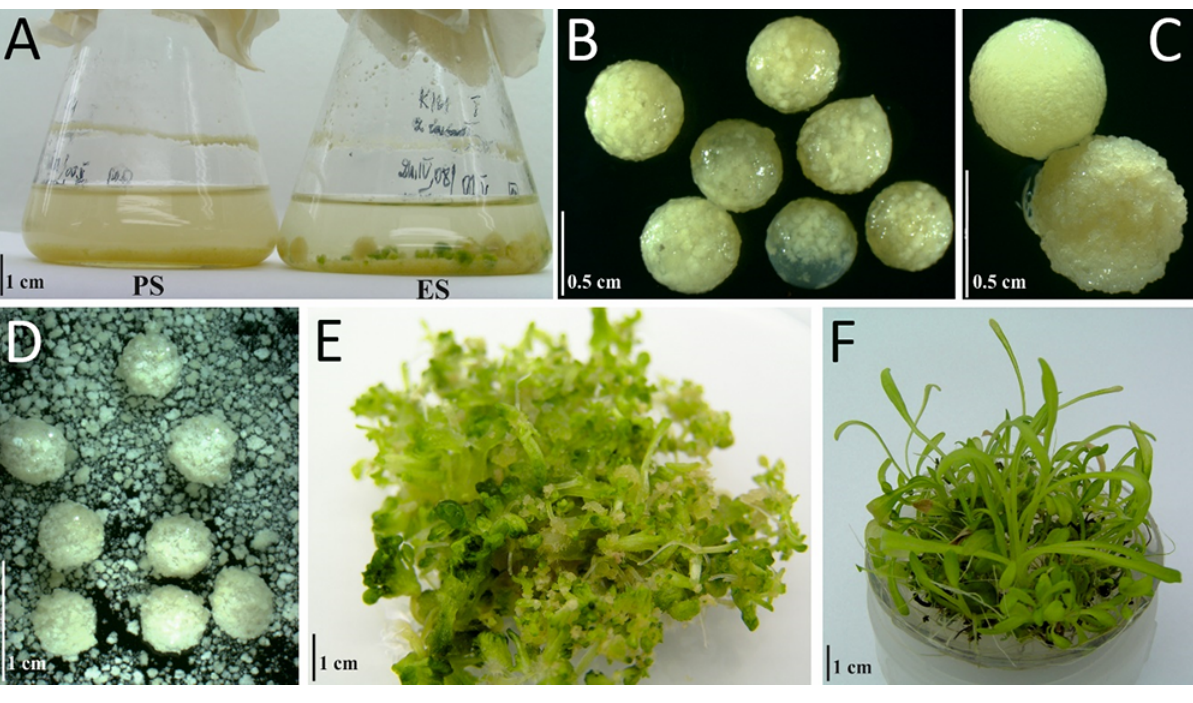
Figure 1 Cryopreservation and restoration of suspension cultures of Gentiana spp. by the encapsulation/dehydration method. ( A ) Embryogenic suspension cultures of G. kurroo Royle in proliferating (PS) and somatic embryo-producing (ES) phases (for more details see Mikuła et al., 2022). ( B ) Freshly prepared control capsule with proembryogenic masses (PEMs) of G. cruciata L. ( C ) Control capsule (on the top) and proliferating tissue aer 14 days of post-thaw culture on agar medium (on the bottom). ( D ) Proliferation and release of cell aggregates of G. tibetica King. into liquid nitrogen (LN) (Day 21 of culture). ( E ) Numerous somatic embryos of G. cruciata developed from suspension culture recovered aer storage in LN; 4 months on agar medium. ( F ) Plantlets of G. kurroo regenerated aer cryopreservation (Mikuła, Tomiczak, et al.,